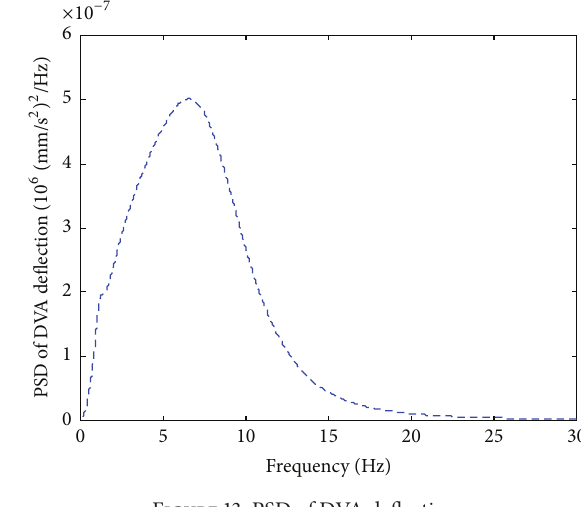
Figure 13: PSD of DVA deflection.